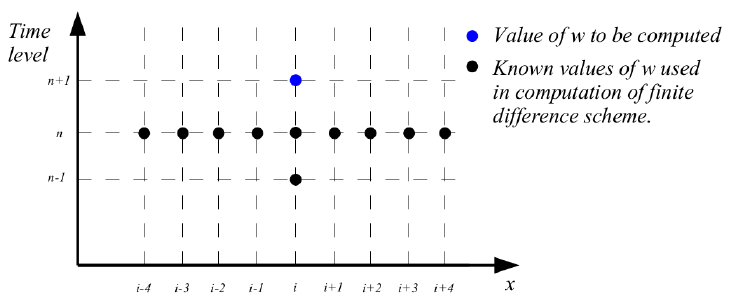
Figure 5. Stencil for the spatial and temporal discretisation of the function w in the finite differ- ence